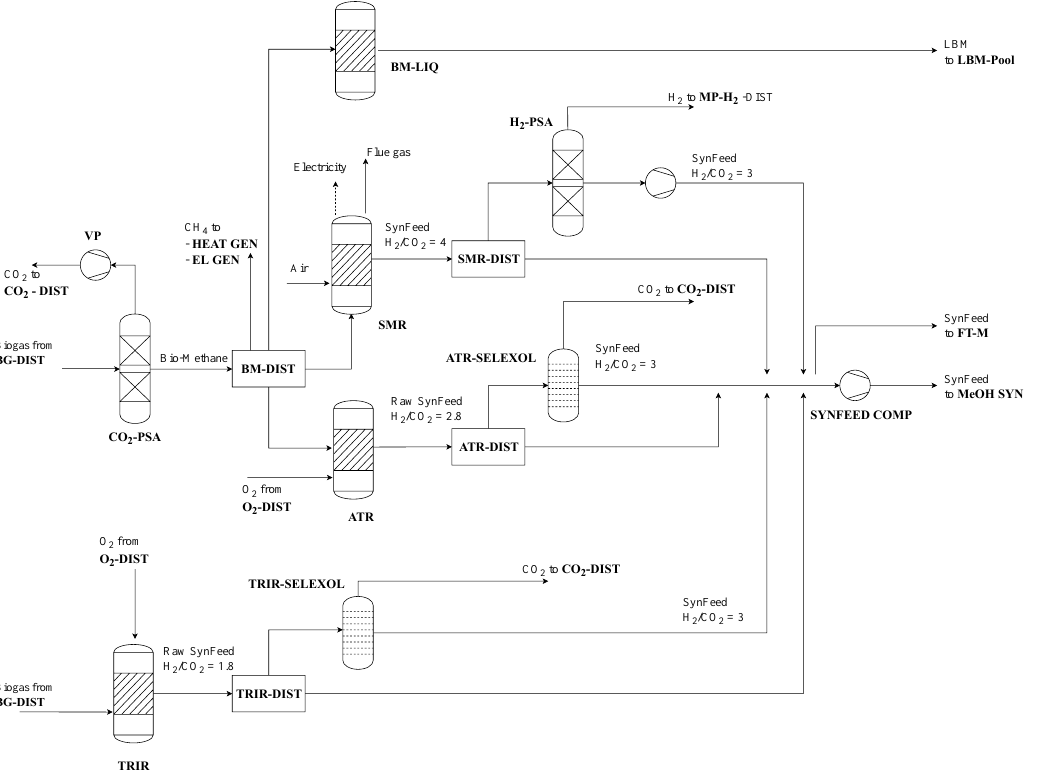
Figure 7. Biogas utilization and SynFeed upgrading process section of renewable refinery superstructure.